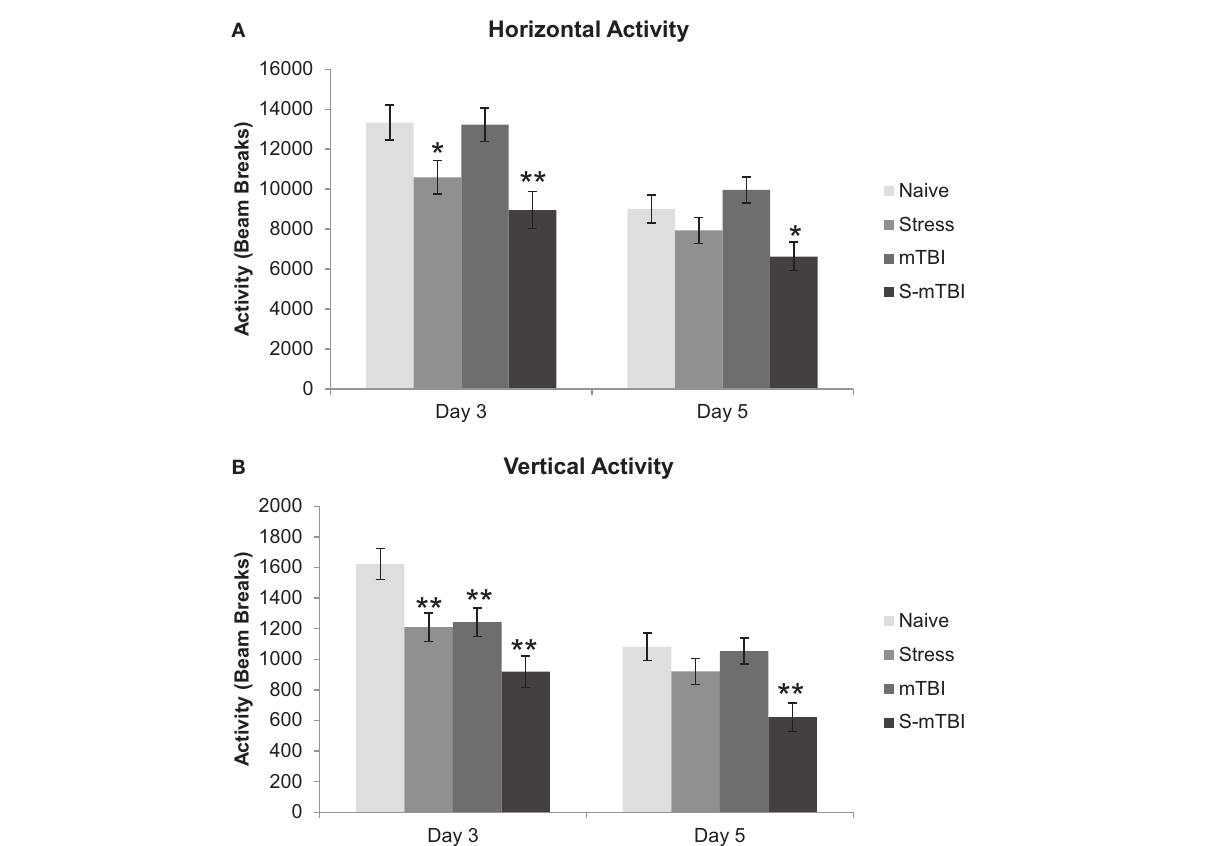
FIGURE 1 | Effects of stress, mTBI, or the combination on open field activity . Activity was measured for 60min at baseline (BL), and 3 and 5days post injury and the number of beam breaks was collected. (A) Horizontal activity (measure of general health and movement) of the animals throughout